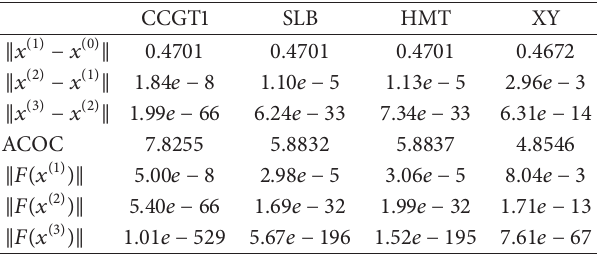
Table 6: Numerical results for Example 2.